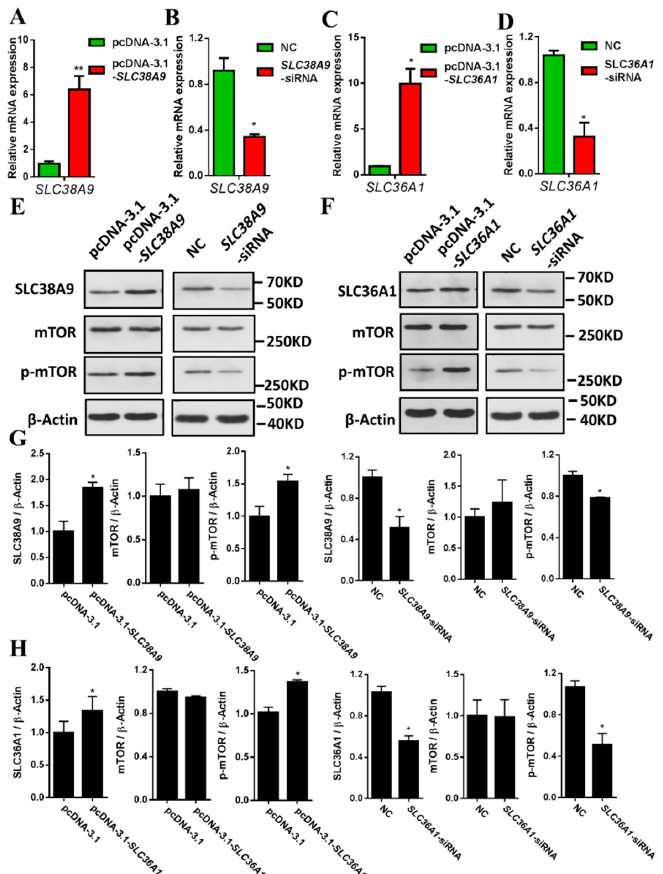
Figure 2. The effects of SLC38A9 or SLC36A1 overexpression and inhibition on mTOR phosphorylation in C2C12 cells. ( A ) The mRNA expression of SLC38A9 after overexpression of SLC38A9. ( B ) The mRNA expression of SLC38A9 after inhibition of SLC38A9. ( C ) The mRNA expression of SLC36A1 after overexpression of SLC36A1. ( D ) The mRNA expression of SLC36A1 after inhibition of SLC36A1. ( E ) C2C12 cells were transfected with pcDNA3.1-SLC38A9 construct or siRNA to overexpress or knockdown SLC38A9. Immunoblotting analysis of protein samples with anti-SLC38A9, anti-mTOR, anti-phospho-mTOR, or anti- β -Actin antibody. ( F ) C2C12 cells were transfected with pcDNA3.1-SLC36A1 construct or siRNA to overexpress or knockdown SLC36A1. Immunoblotting analysis of protein samples with anti-SLC36A1, anti-mTOR, anti-phospho-mTOR, or anti- β -Actin antibody. ( G ) Densitometric analysis of the immunodetection of SLC38A9, mTOR or phospho-mTOR relative to β -Actin loading control from ( E ). ( H ) Densitometric analysis of the immunodetection of SLC36A1, mTOR or phospho-mTOR relative to β -Actin loading control from ( F ). Values are the mean ± SEM; n = 3; * p < 0.05; ** p < 0.01.